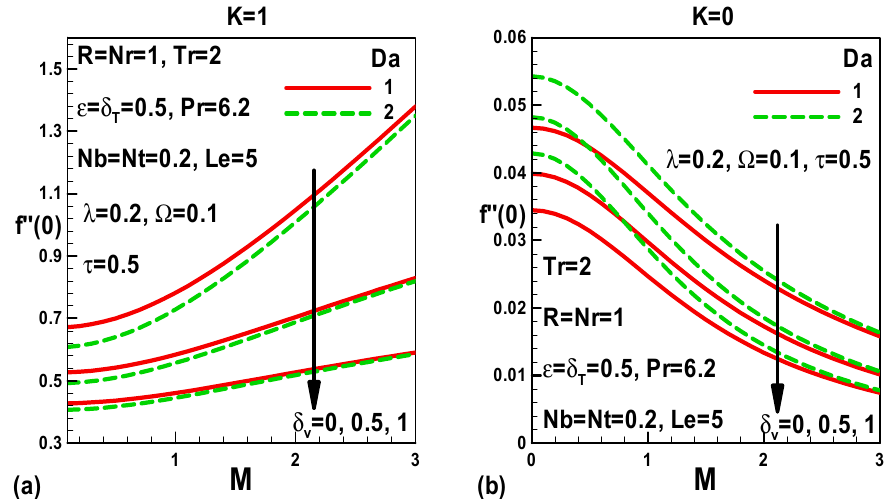
Figure 11. Effects of Darcy number, velocity slip, and magnetic parameters on skin friction ( a ) with pressure gradient and ( b ) without pressure gradient.